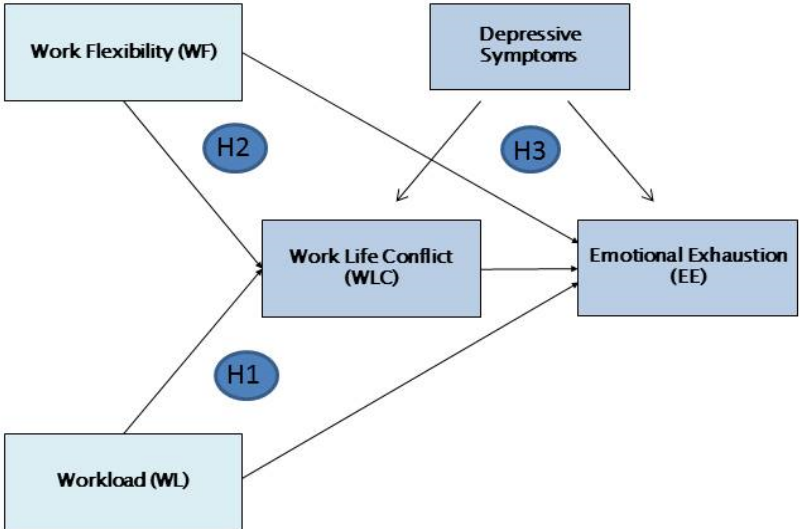
Figure 1. Schematic illustration of the investigated research model with its three hypotheses (H1–